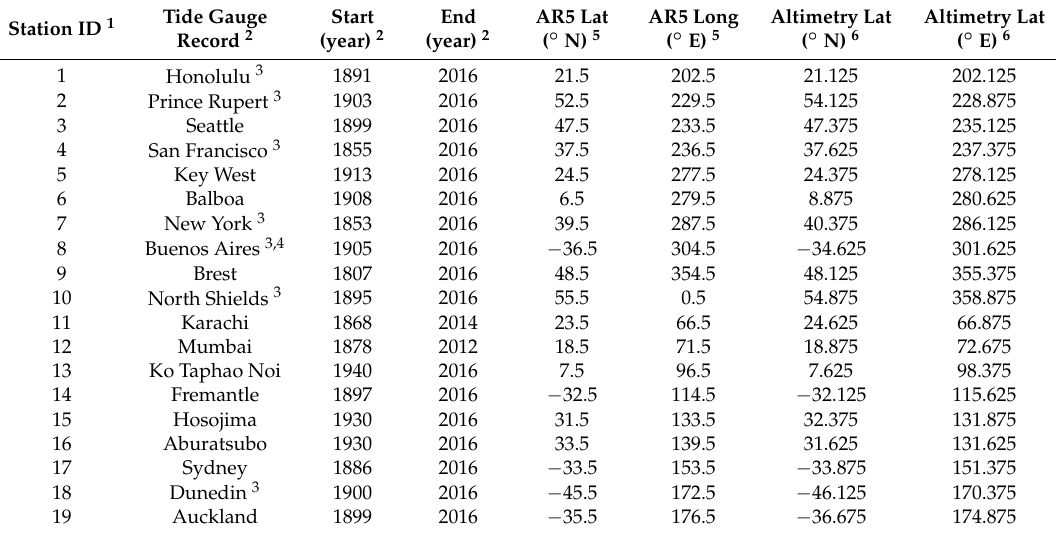
Table 1. Summary of tide-gauge, AR5 model-projection and altimetry data used in this study. Station ID